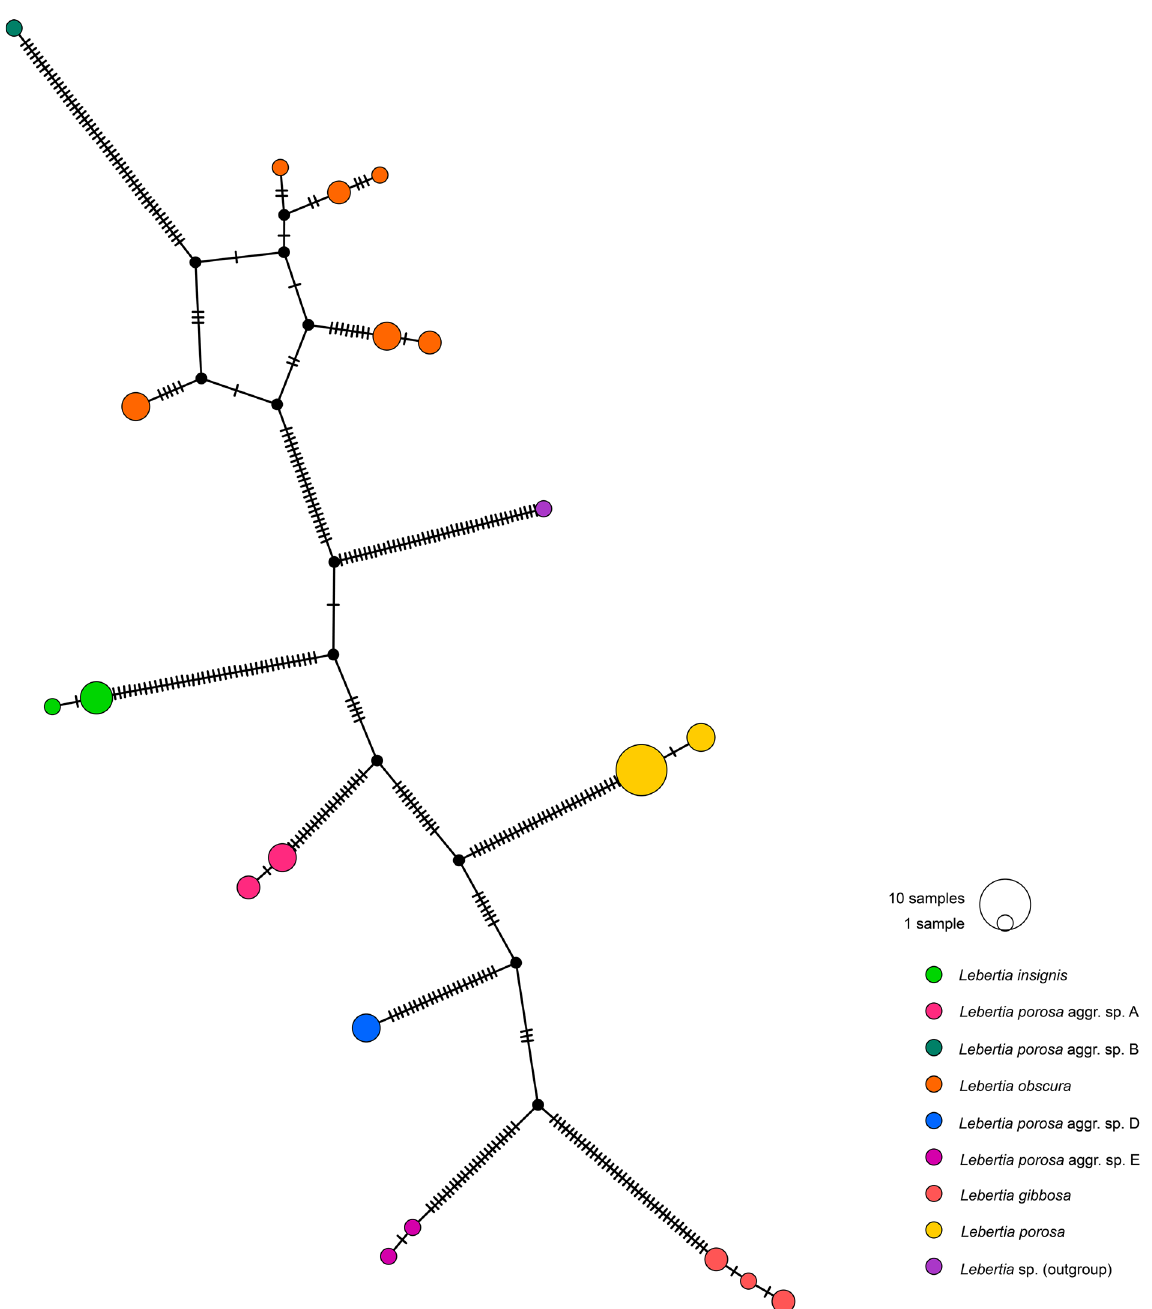
Fig. 5. Lebertia ( Pilolebertia ) spp. from Norway. TCS haplotype network of COI sequences constructed with